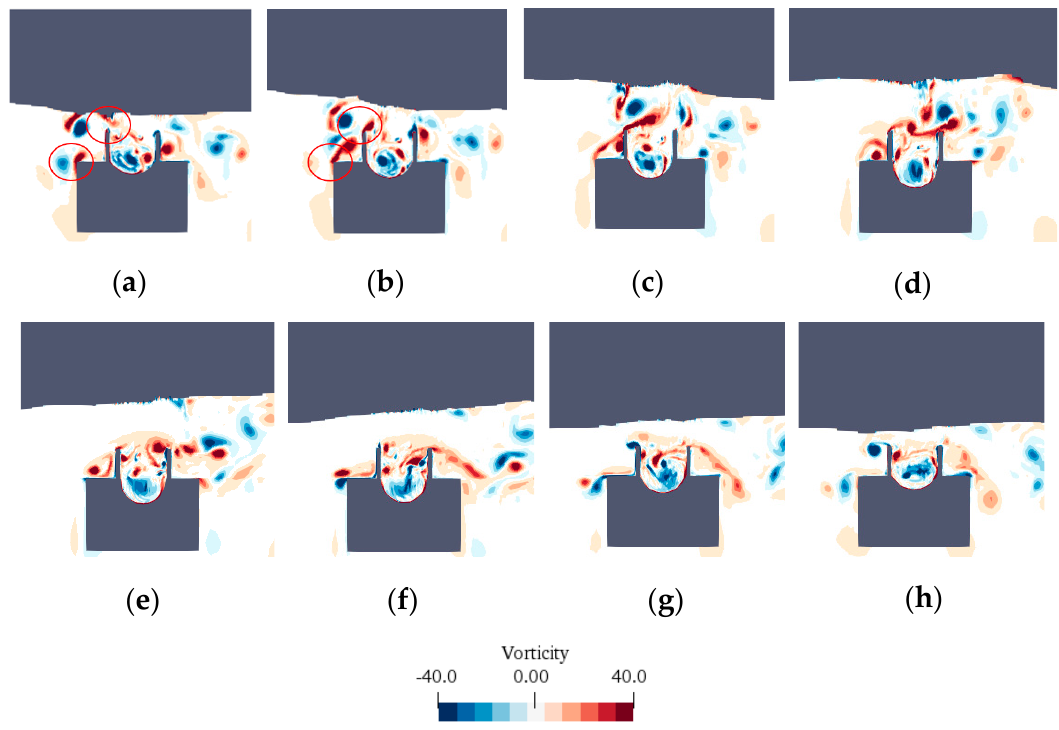
Figure 22. The instantaneous vorticity contour for T = 1.6 s in one wave period ( H = 0.1 m and d = 0.18 m): ( a ) t = 1/8 T , ( b ) t = 2/8 T , ( c ) t = 3/8 T, ( d ) t = 4/8 T , ( e ) t = 5/8 T , ( f ) t = 6/8 T , ( g ) t = 7/8 T , and ( h ) t = 8/8 T .